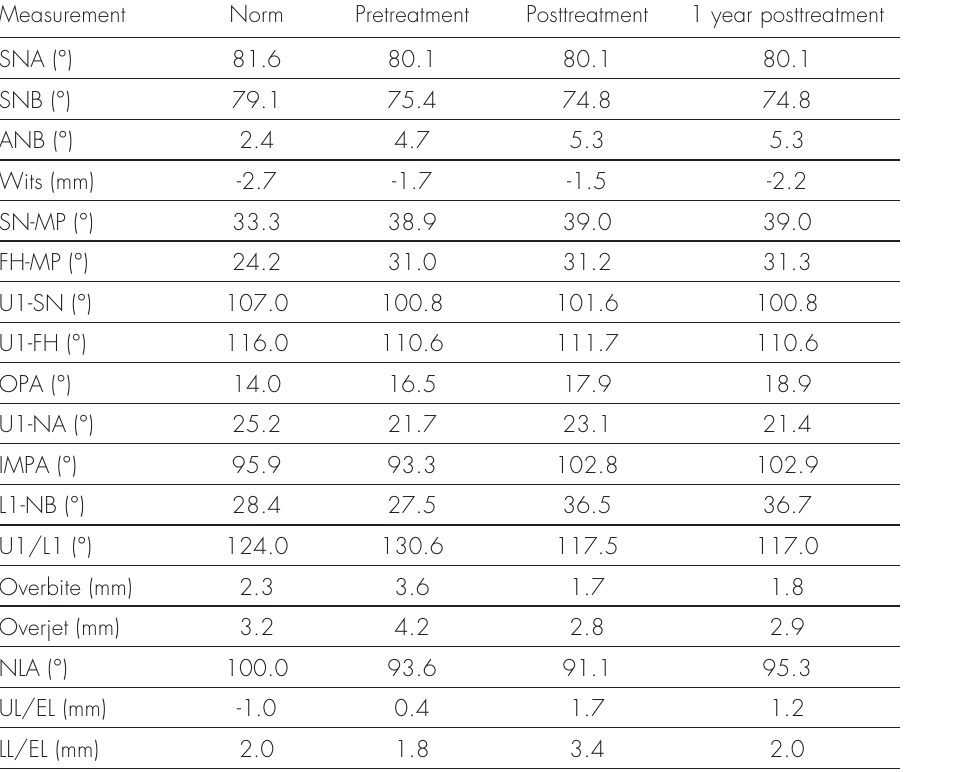
Table I. Cephalometric measurements. Measurement Norm